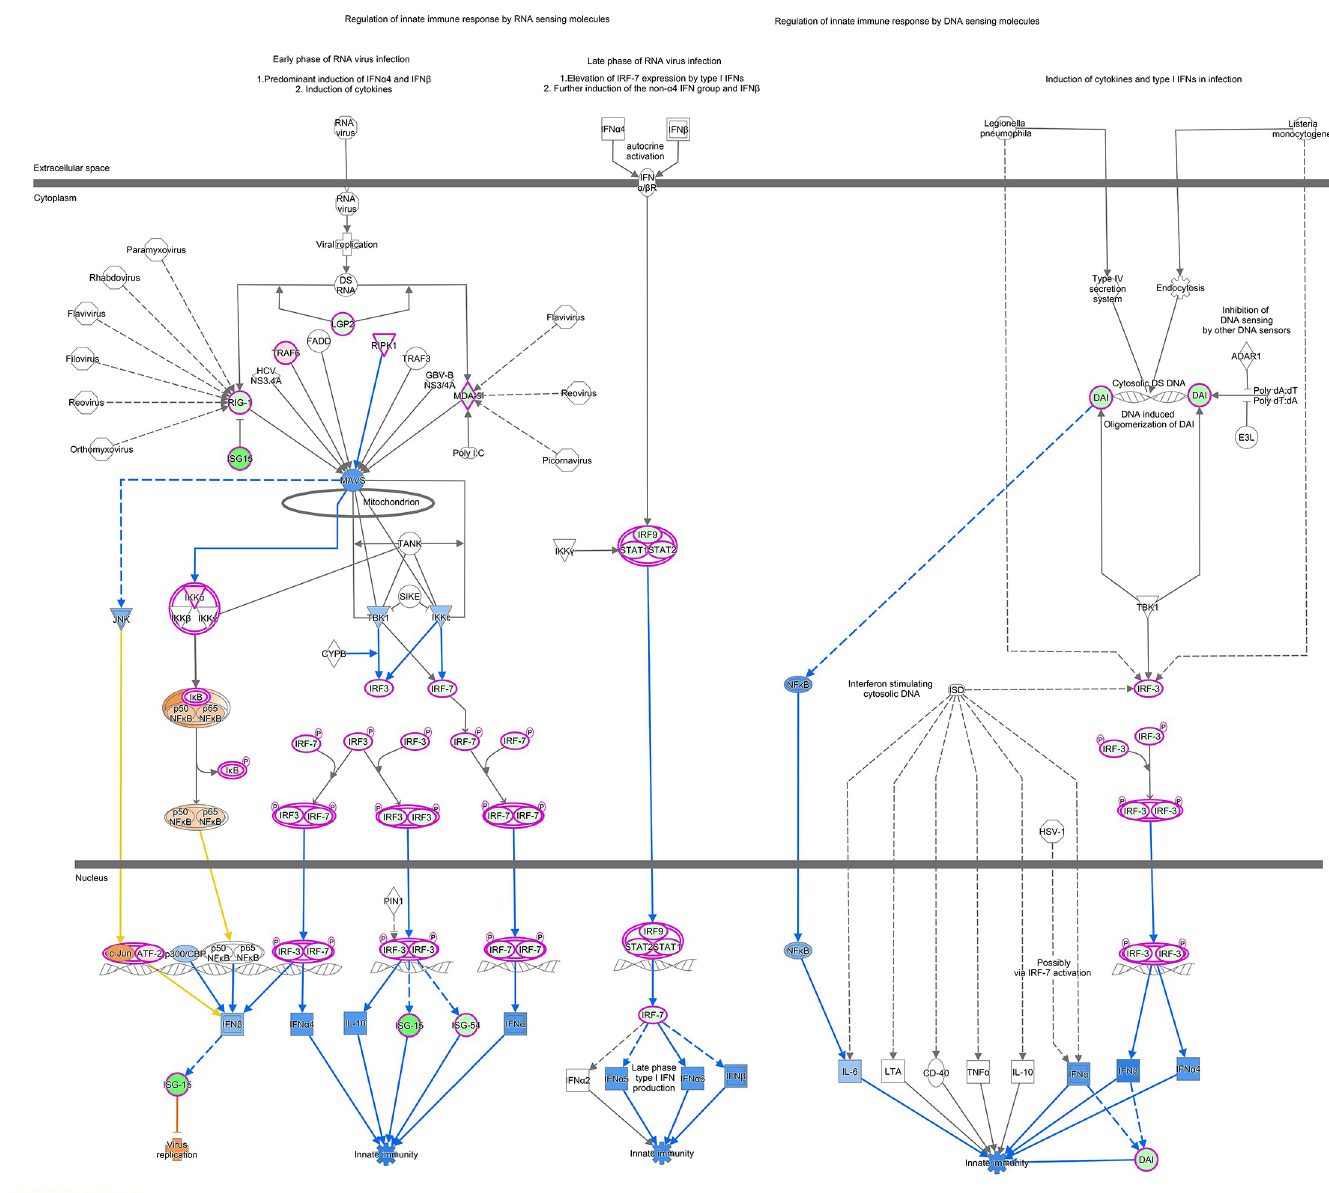
Fig 3. IPA canonical pathway, “Activation of IRF by Cytosolic Pattern Recognition Receptors”. The nodes represent genes/molecules/complexes in a pathway, and the lines and arrows between nodes indicate known relationships from the Ingenuity Knowledge Base. Nodes with purple outline indicate molecules that were measured as differentially expressed in our dataset, with the intensity of coloured infill indicating the level of up (red) or down (green) regulation of Holstein relative to Sahiwal. The blue- and orange-coloured molecules and lines are predicted activation states generated by the Molecular Activity Predictor function in Ingenuity Pathway Analysis (IPA). Blue colour indicates a predicted inhibition, and orange a predicted activation state in Holstein relative to Sahiwal. Yellow lines indicate relationships where our findings are inconsistent with the state of the downstream molecule. Broad lines with explanatory text beside the pathway indicate the cellular location of molecules in the pathway. The molecules in the pathway are given shapes that indicate their functional class (Nested Circle/Square = Group/Complex, Horizontal ellipse = Transcriptional Regulator, Vertical Ellipse = transmembrane receptor, Vertical Rhombus = enzyme, Square = Cytokine/Growth Factor, Triangle = Kinase, Vertical Ellipse = Transmembrane Receptor, Circle = other). The edges between molecules are also differentiated to indicate the type of relationship between them. Solid lines are direct relationships and dashed lines are